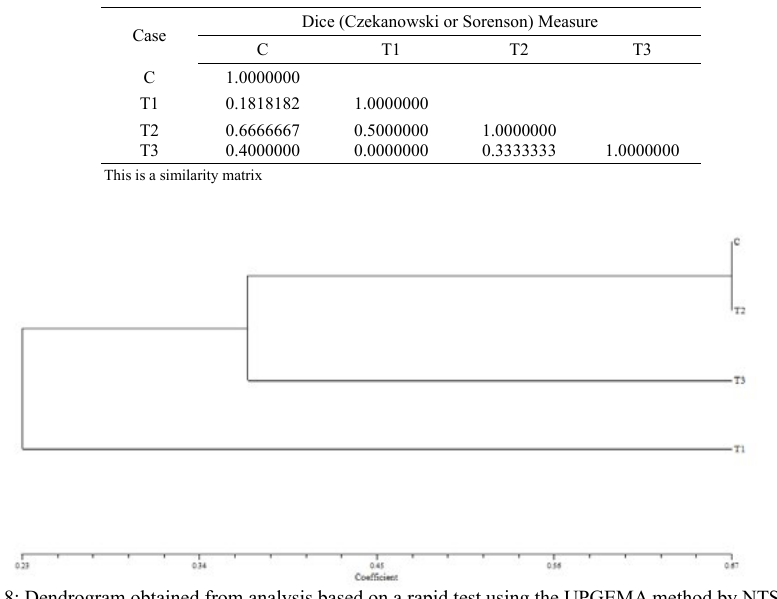
Fig. 8: Dendrogram obtained from analysis based on a rapid test using the UPGEMA method by NTSYS-PC